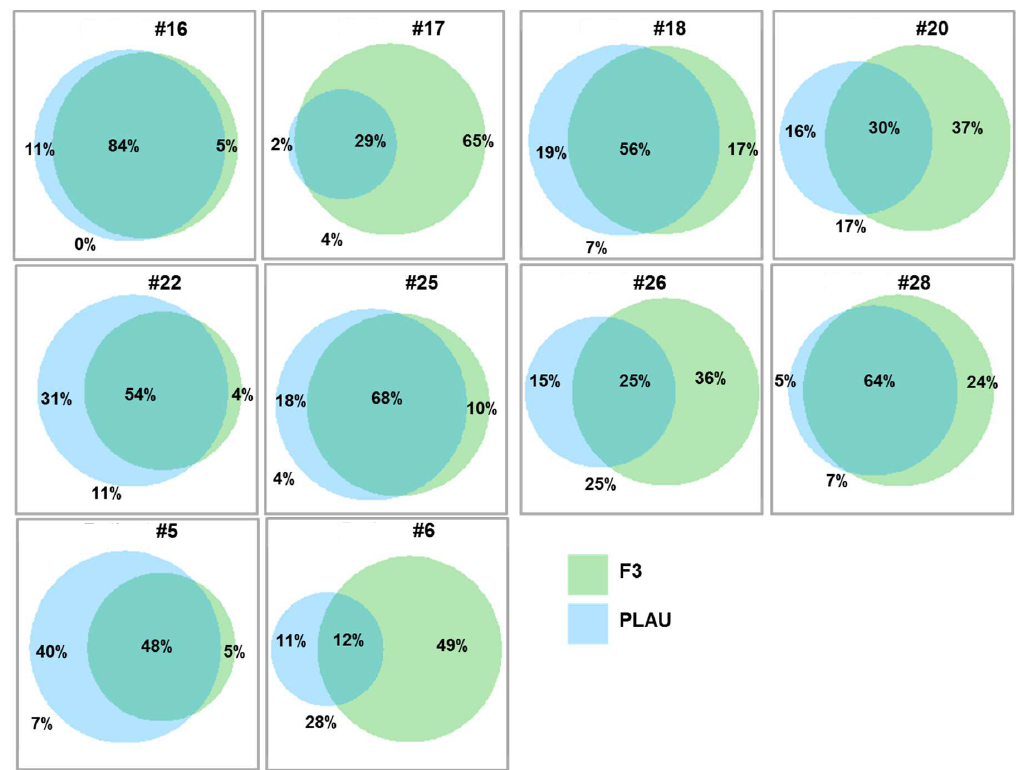
Figure 7. Overlap in F3 and PLAU expression in cancer cells from individual tumors. Venn diagrams examining the overlap between the pro-coagulant ( F3 -positive) and pro-fibrinolytic ( PLAU -positive) transcriptional programs in cancer cells from individual tumors (GSE103322). Note that the extent of the overlap of F3 and PLAU expression varied greatly depending on the tumor analyzed, ranging from 12% to 84% of cancer